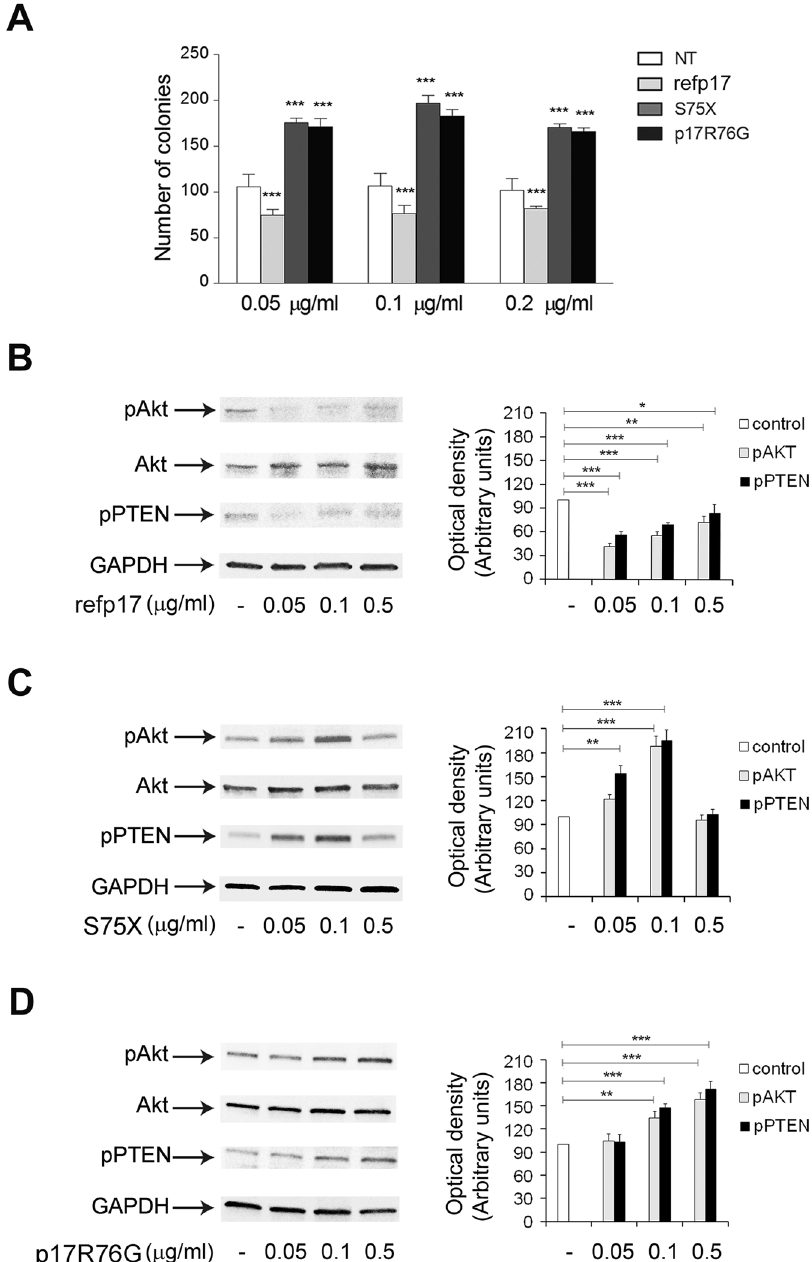
Figure 4. Effect of refp17, S75X and p17R76G on B-cell activity. ( A ) Raji were plated in twelve-well plates and, after four days, medium was replaced by fresh medium with the indicated concentration of refp17, S75X and p17R76G. Cells not treated (NT) were used as negative control. The cell growth was analyzed by using MTT. Data represent the average number of colonies ± SD from three independent experiments performed in triplicate. The statistical significance between control and treated cultures was calculated using one-way ANOVA performed separately for each concentration of p17 variants and Bonferroni’s post-test was used to compare data; *** P < 0.001. ( B – D ) Cells were treated for 5 min with 0.05, 0.1, 0.5 μ g/ml of refp17 ( B ), S75X ( C ) and p17R76G ( D ). Untreated cells were used as control. Western blot analysis of Raji lysates shows that refp17 inhibits the activation of Akt and maintains PTEN in an active state ( B ), as shown by the respective phosphorylation state at any concentration tested, verified by densitometric analysis and plotting of the pAkt/ Akt and pPTEN/GAPDH. On the contrary, either S75X or p17R76G induce the activation of Akt and maintains PTEN in an inactive state ( C , D ), as shown by the increased phosphorylation, verified by densitometric analysis and plotting of the pAkt/Akt and pPTEN/GAPDH. In the left panel blots from one representative experiment of three with similar results are shown. In the right panels, values reported for phosphorylation of Akt and PTEN are the mean ± SD of three independent experiments. Statistical analysis was performed by one-way ANOVA and the Bonferroni’s post-test was used to compare data; * P < 0.05; ** P < 0.01; *** P <